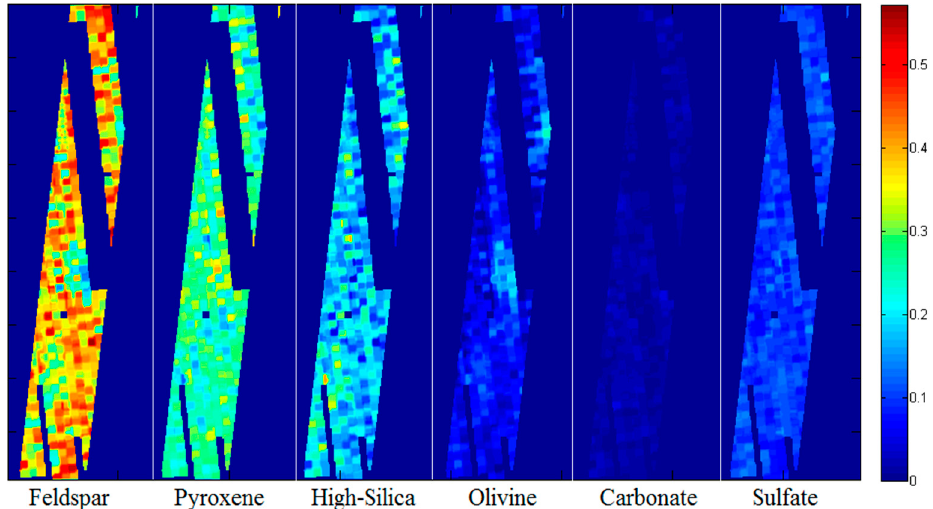
Figure 22. Contribution Maps for I08152027; Color bar represents contribution level. Each image represents the sum of all minerals in the respective group.